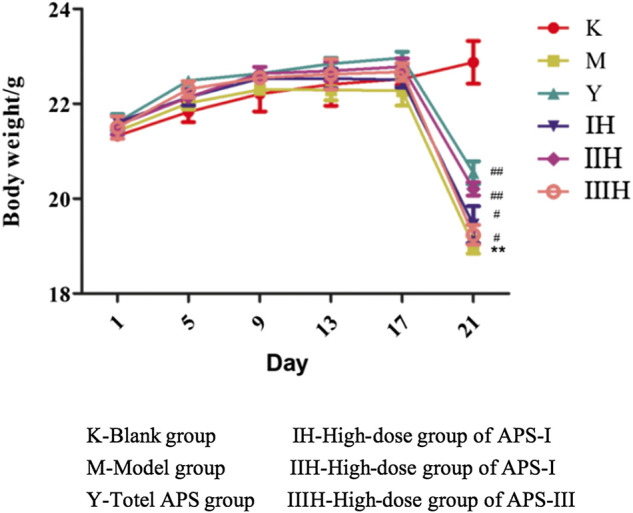
Effects of APS of different MW on the body weight of mice. (Take the high-dose group for example), n = 9, x ± s. **p < 0.01 vs blank control group; #
p < 0.05, ##
p < 0.01 vs model group.